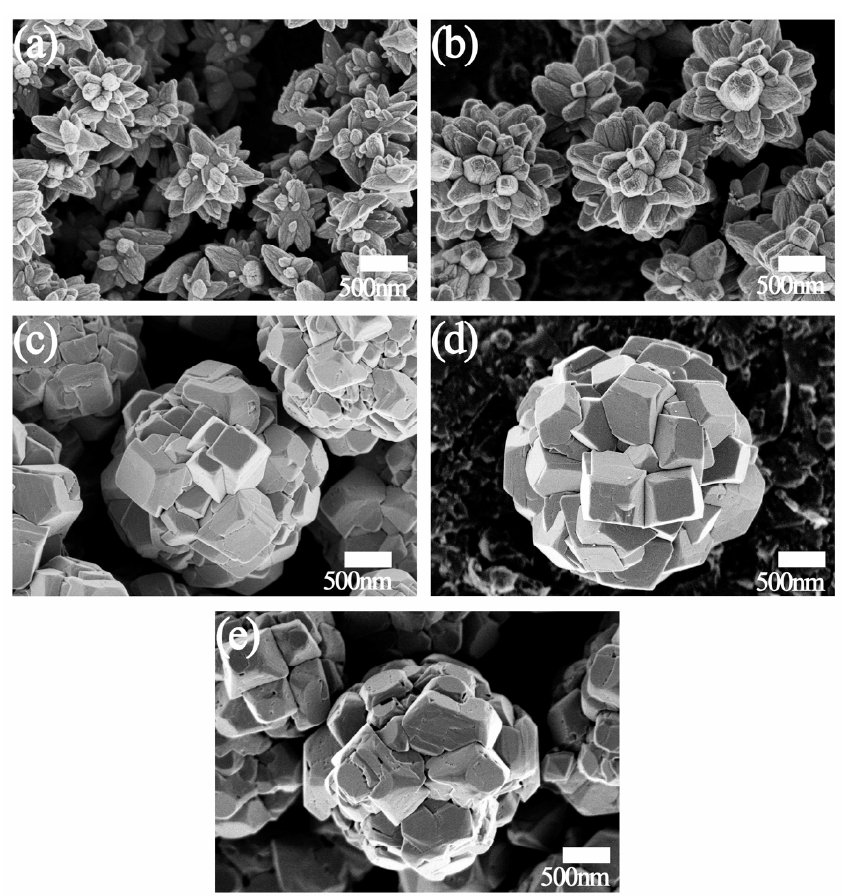
Figure 3. Field emission scanning electron microscopy images of the samples synthesized by varying the reaction duration at ( a ) 20 min, ( b ) 30 min, ( c ) 6 h, ( d ) 12 h, and ( e ) 24 h, keeping other parameters fixed (e.g. reaction temperature, NaF concentrations and Ti(SO 4 ) 2 ).